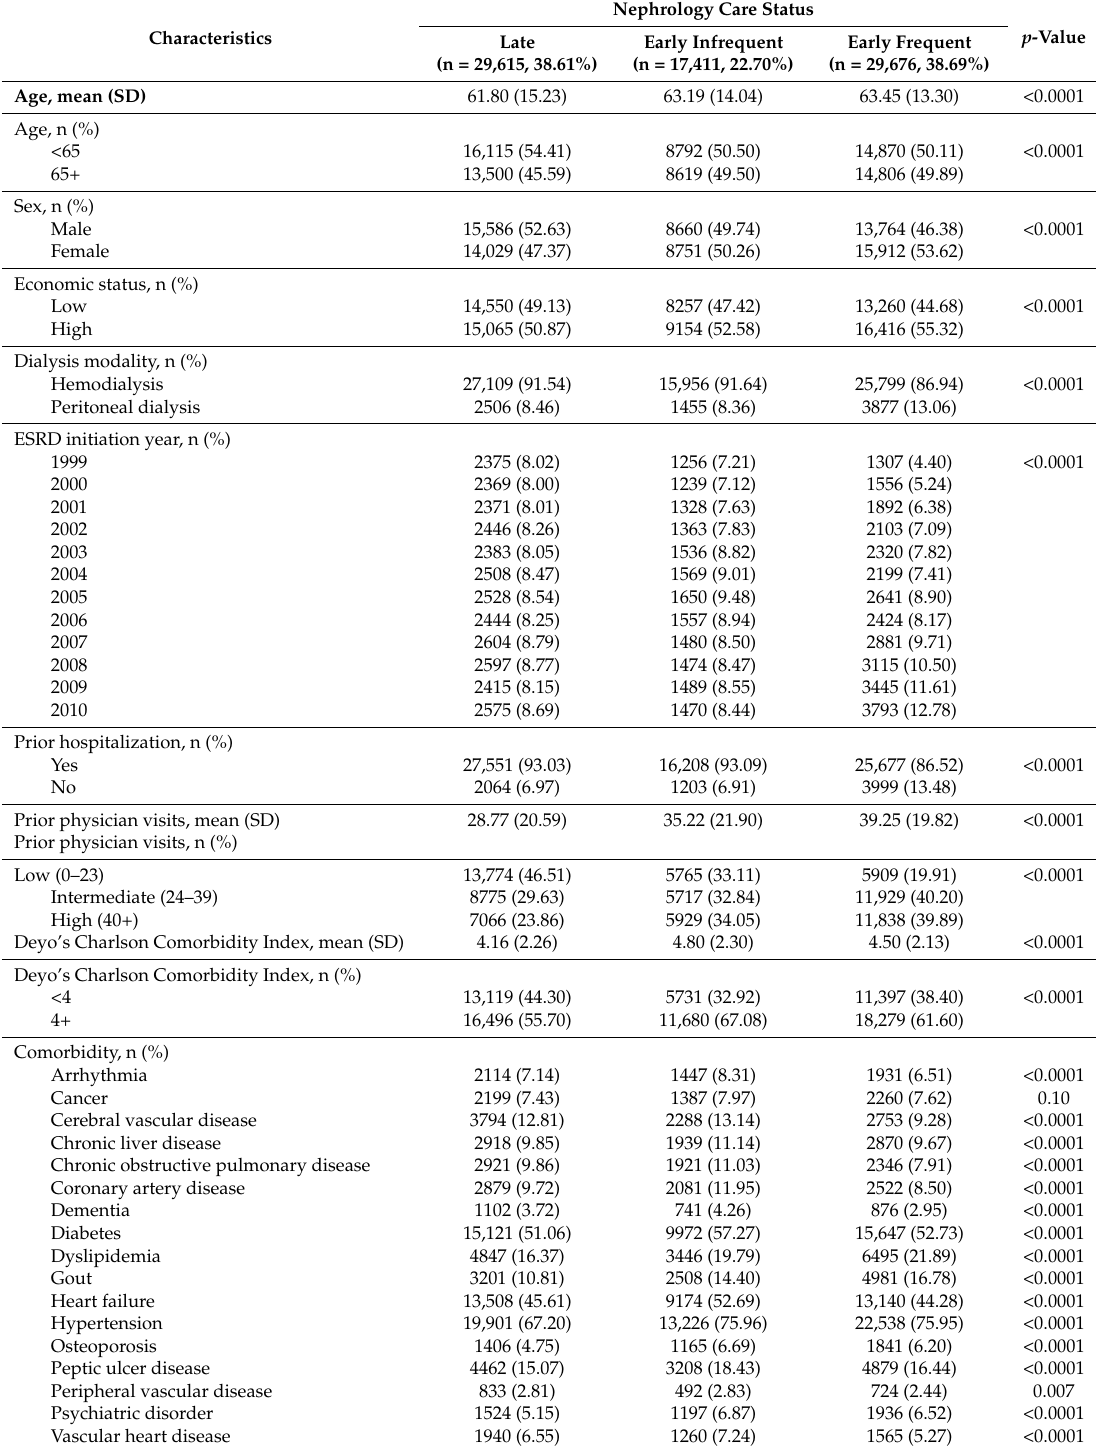
Table 1. Baseline characteristics of